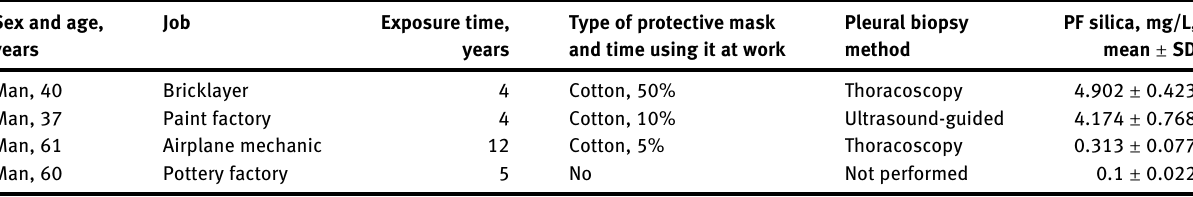
Table  : Characteristics of patients with detectable silica levels in pleural fl uid.